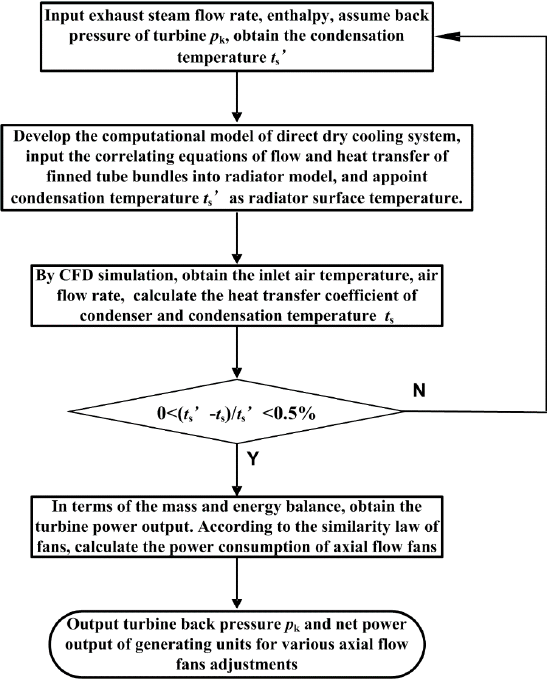
Figure 5. Integration of the backpressure and windward velocity. For a typical case with the inlet steam flow of 34.5 kg/h, non-condensable air flow of 0.0139 × 2/10,000 kg/s, back pressure of 10 kPa, windward velocity of 0.5 m/s, the volume flowrate of air is 1 m 3 /s and environment temperature of − 20 ◦ C, the three dimensional distribution of condensate film thickness is obtained, as shown in Figure